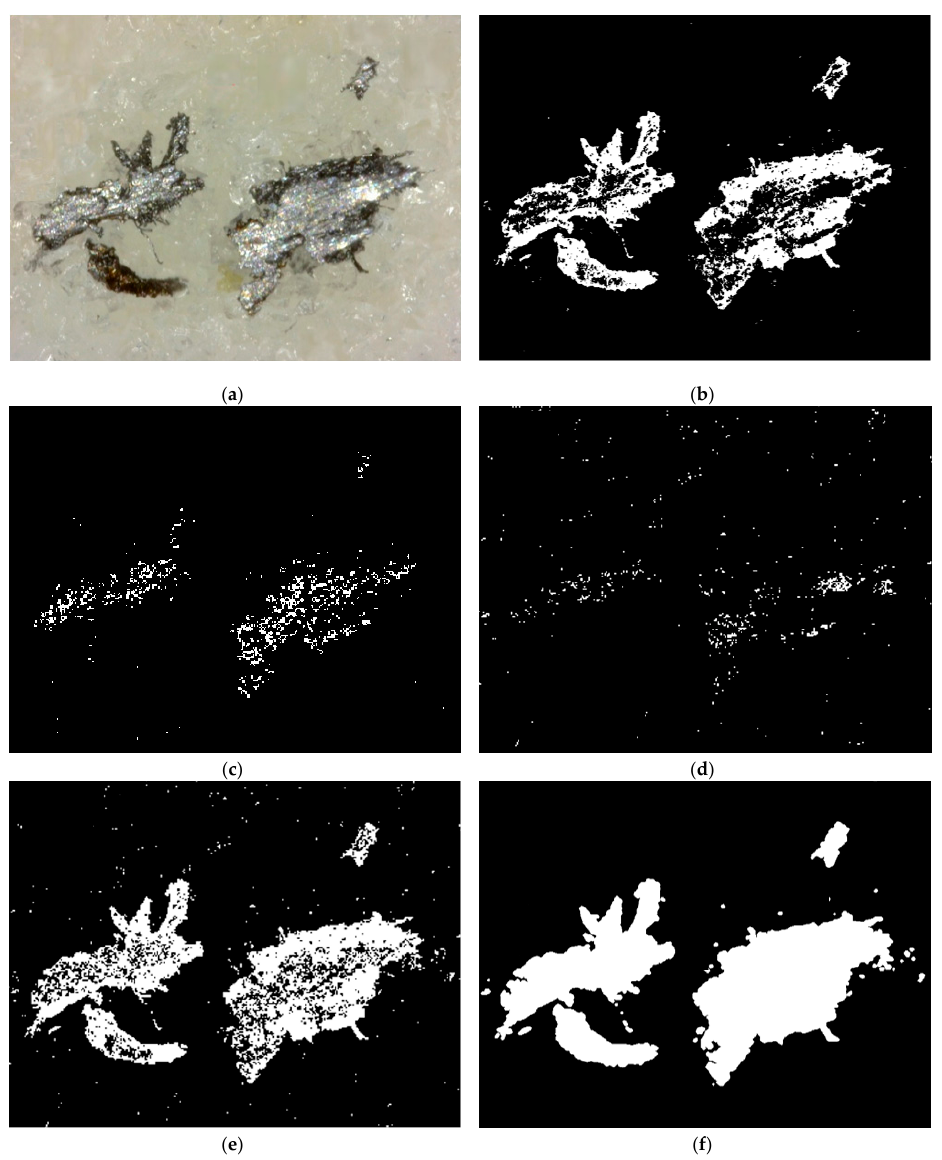
Figure 7. Image processing results: ( a ) original image, ( b ) HSL conversion and binary processing with low L threshold value, ( c ) HSL conversion and binary processing with middle L threshold value, ( d ) HSL conversion and binary processing with high L threshold value, ( e ) overlap processing, and ( f ) morphology processing.